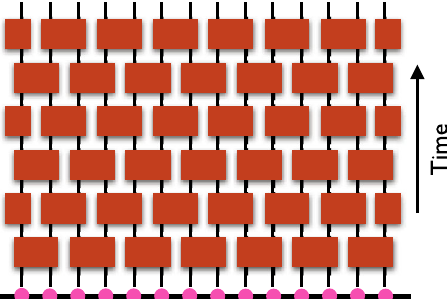
FIG. 1. Left: Random unitary circuit in 1 þ 1 D. Each brick represents an independently Haar-random unitary, acting on the Hilbert space of two adjacent “ spins ” of local Hilbert space dimension q .